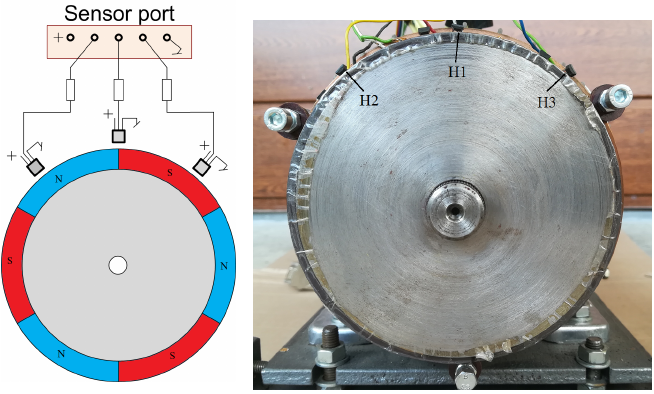
Figure 11. External sensor of the motor shaft position in schematic model ( left figure) and our implementation ( right